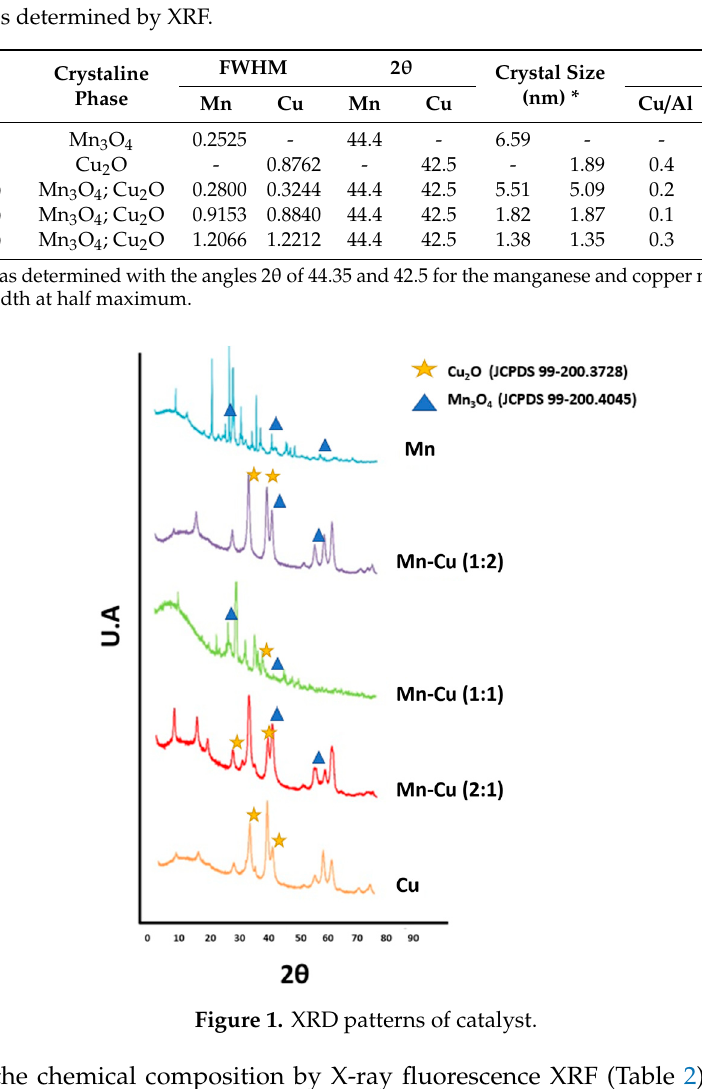
Table 1. Stoichiometric ratio and nomenclature of oxide-mixed catalyst.